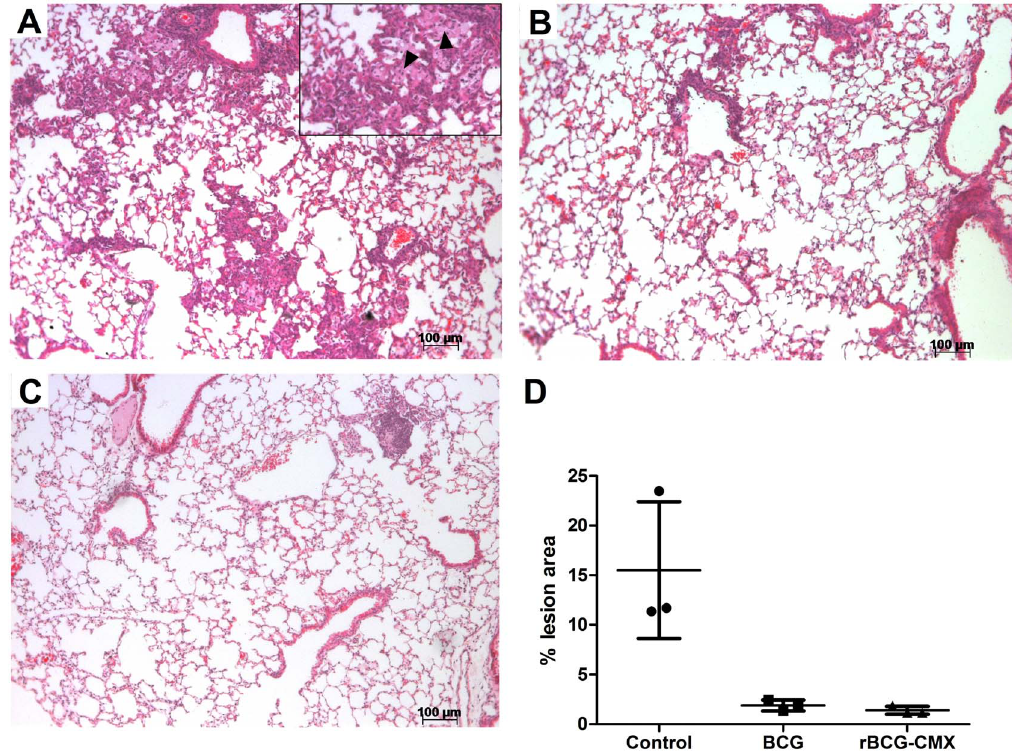
Figure 9. Representative lung pathology of Balb/c mice after challenge. Vaccinated mice were challenged i.v . with 10 5 CFU of virulent M. tuberculosis H37Rv strain. Forty-five days after infection, lung tissue sections from different vaccine groups were harvested. Images are representative of two distinct experiments. HE staining is shown with 20X magnification. (A) Unvaccinated group. Black arrowheads: Foamy macrophages. (B) BCG- vaccinated group. (C) rBCG-CMX vaccinated group. (D) Histological score of the lesion area from three representative fields obtained by AxioVision 4.9.1 software, through ratio of lesioned and total field area. Data are presented as percentages (%).